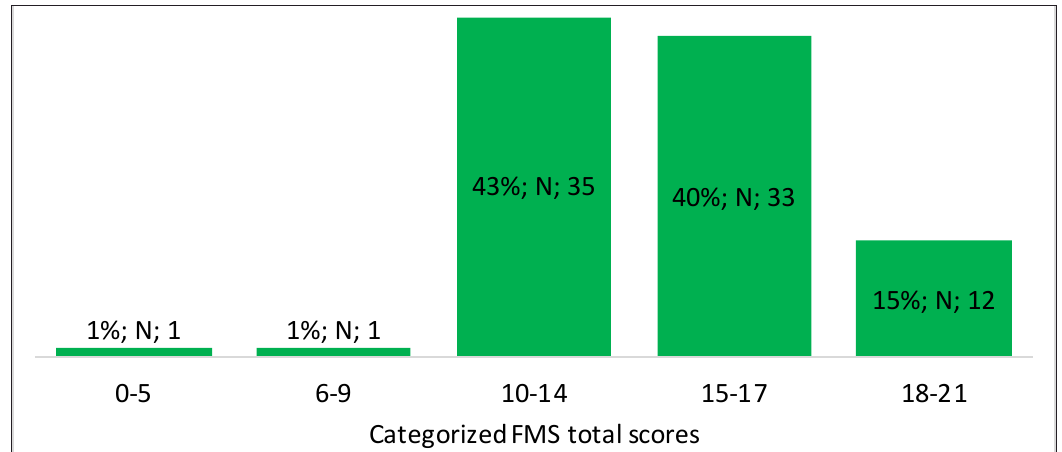
Fig. 1. FMS total score distribution among all volunteers before training Table 1. 12 week strength training program*